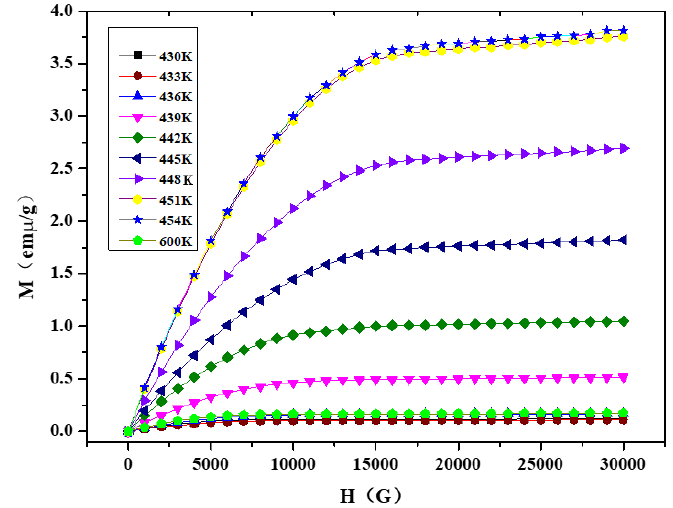
Figure 19. Magnetization isotherms of the Ni 2 − x Co x In 3 (x = 0.200) alloy.